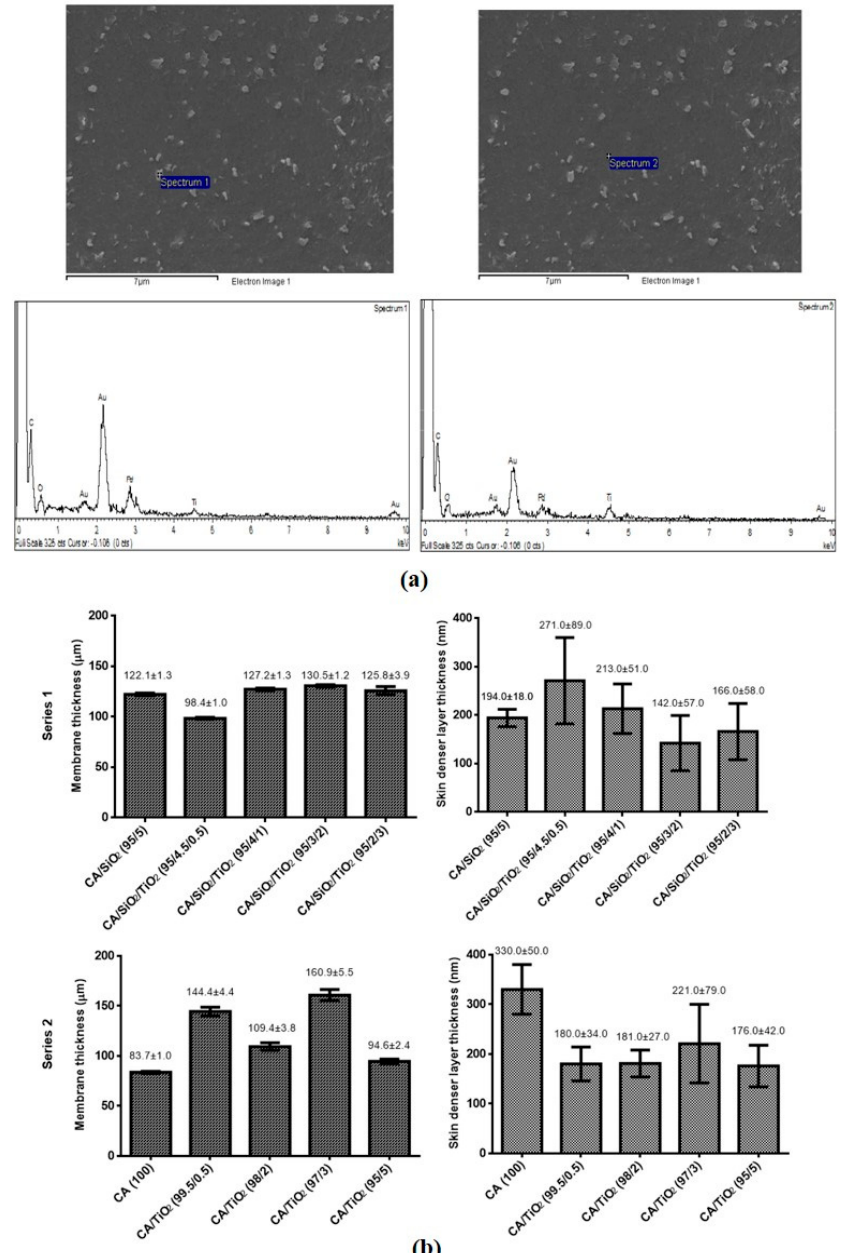
Figure 4. ( a ) Bottom SEM images of the CA / TiO 2 (98 / 2) membrane analyzed by EDS. Spectrum 1 EDS analysis was performed in a surface deposit and spectrum 2 EDS analysis was performed in the bottom flat surface of the membrane. ( b ) Membrane thickness ( µ m) and skin dense layer (nm) thickness for the membranes in series 1 and series 2. The total membrane thickness and dense layer thickness were measured from the SEM images of the series 1 and series 2 membranes’ cross sections using ImageJ software (procedure illustrated in Appendix D).